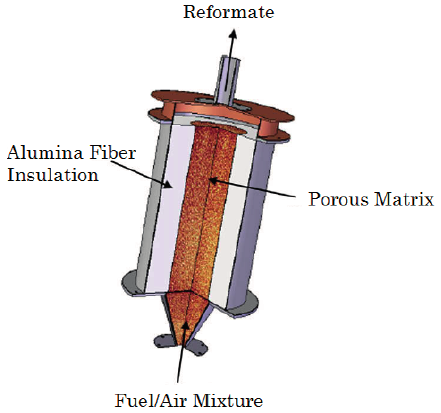
Figure 2. Reformer module used by Al-Hamamre et al.